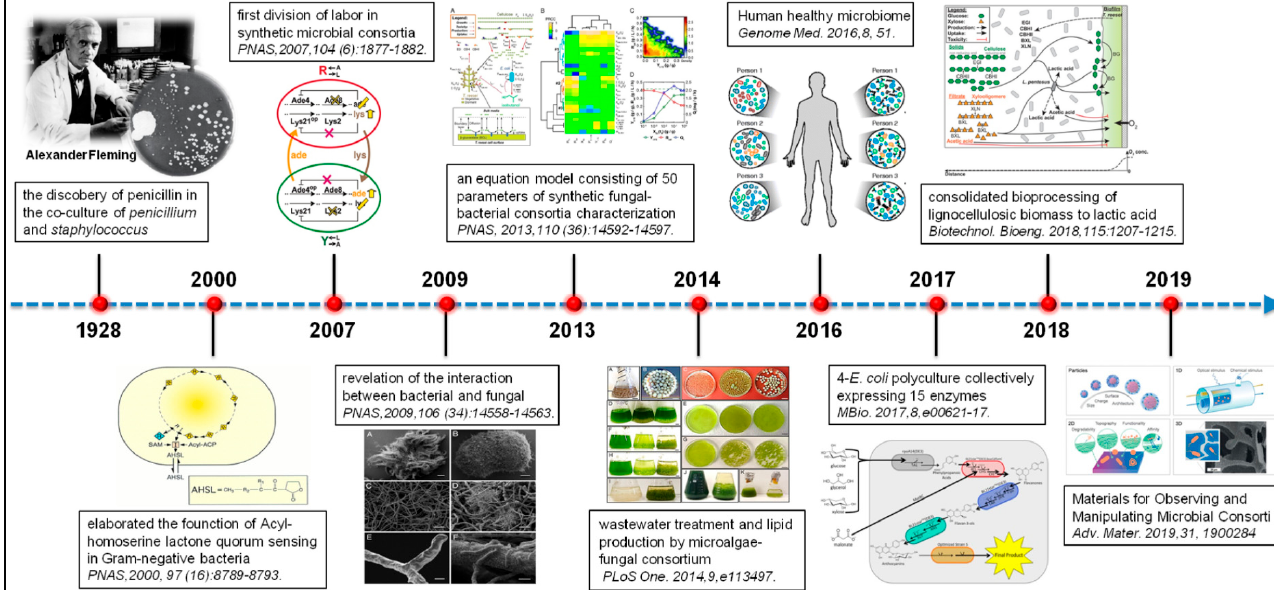
Figure 1. A schematic timeline representing the main milestones results related to the microbial consortia statement. Reprinted with permission from Qian et al. (2020). Biotechnological potential and applications of microbial consortia. Biotechnology Advances [32]. Copyright (2020) Elsevier.